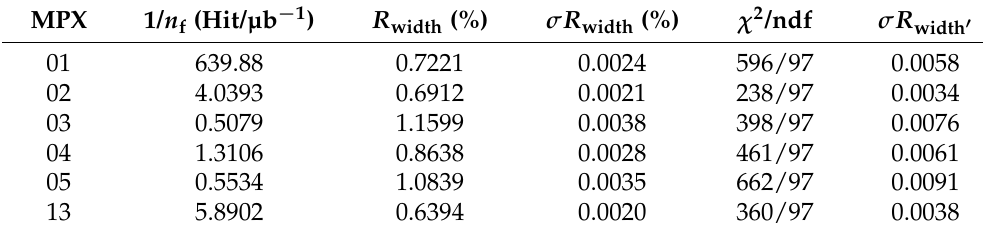
Figure 5. Luminosity ratio MPX/MPXav for two of the six MPX devices (MPX01 and MPX13) with highest particle flux (MPX01-05 and MPX13). The distributions are approximated by Gaussian fits. The width of the Gaussian is an estimate of the LB-by-LB uncertainties. LHC fills from June to November 2012. The “av” stays for “average”, and “LB” stays for “luminosty block”. Taken from Ref. [11]. Table 2. Normalization factor, 1/ n f , width of Gaussian fits of luminosity ratio MPX/MPXav for the six MPX devices (MPX01-05 and MPX13), shown in Figure 5. The χ 2 /ndf values indicate that, in addition to the statistical uncertainties, some systematic uncertainties are present. For a realistic width uncertainty determination of an individual device, the errors are scaled to obtain χ 2 /ndf = 1. The “av” stays for “average”, and “ndf” stays for “number of degrees of freedom”. Taken from Ref.